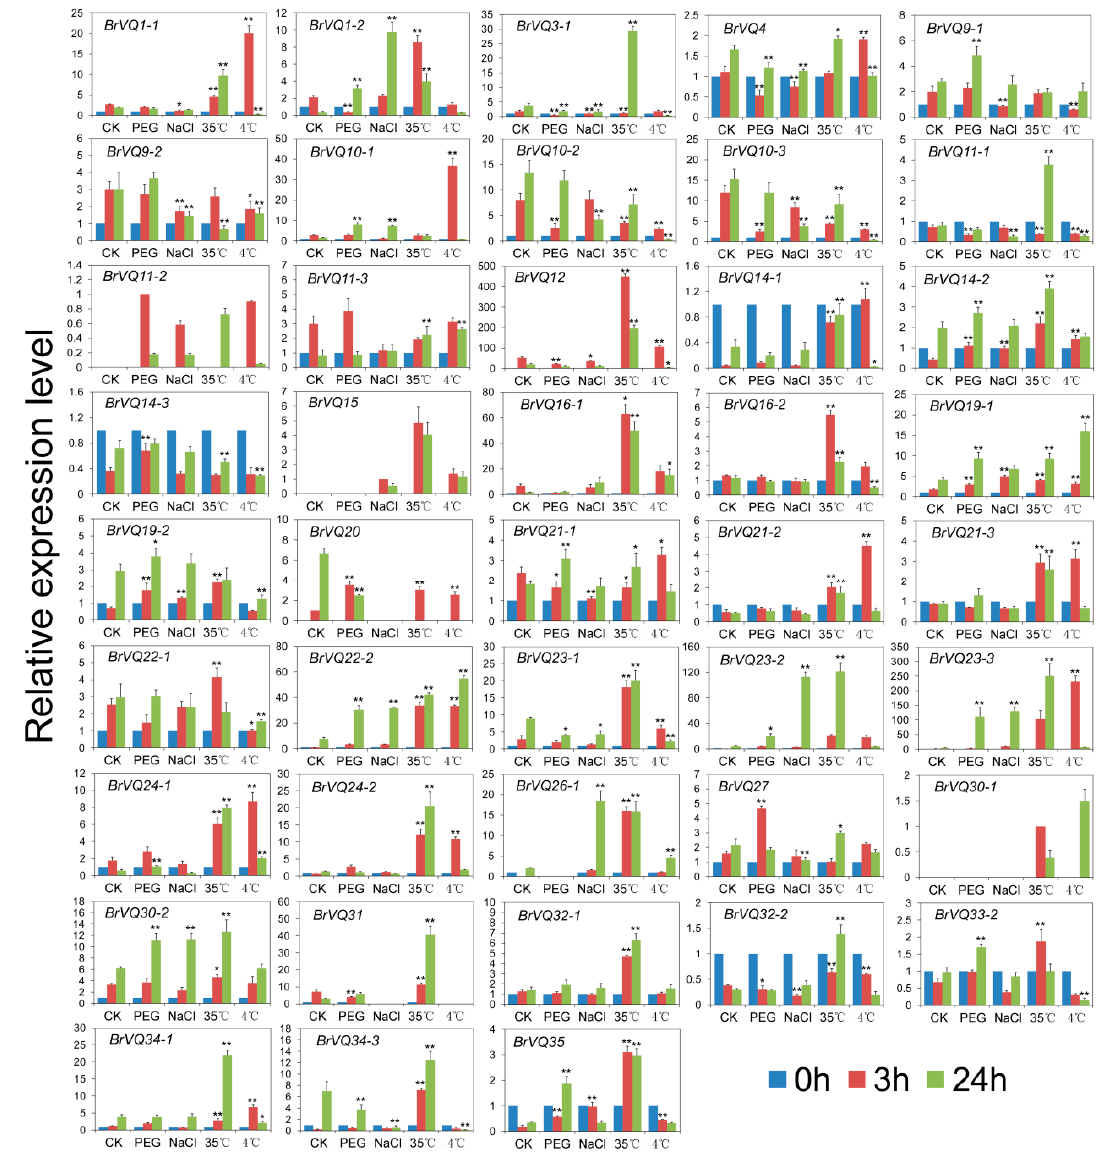
Figure 8. Expression analysis of the BrVQ genes under abiotic stresses. Three-week-old plants were treated with 20% ( w / v ) PEG 6000 , 20 mmol/L NaCl, 35 °C, and 4 °C for 0, 3, and 24 h before the mature leaves were harvested. Expression of the BrVQ genes were normalized to those of BrActin and shown relative to the expression of CK at 0 h, except for four BrVQ genes ( 11-2 , 15 , 20 , 30-1 ), whose expression levels were related to the expression of CK treated with PEG, NaCl, CK, 35 °C at 3 h, respectively. The 2 −ΔΔ C t method was used to calculate the expression of target genes in different tissues. * indicated that the expression level is significantly different from the value of the control (* p < 0.05, ** p < 0.01).